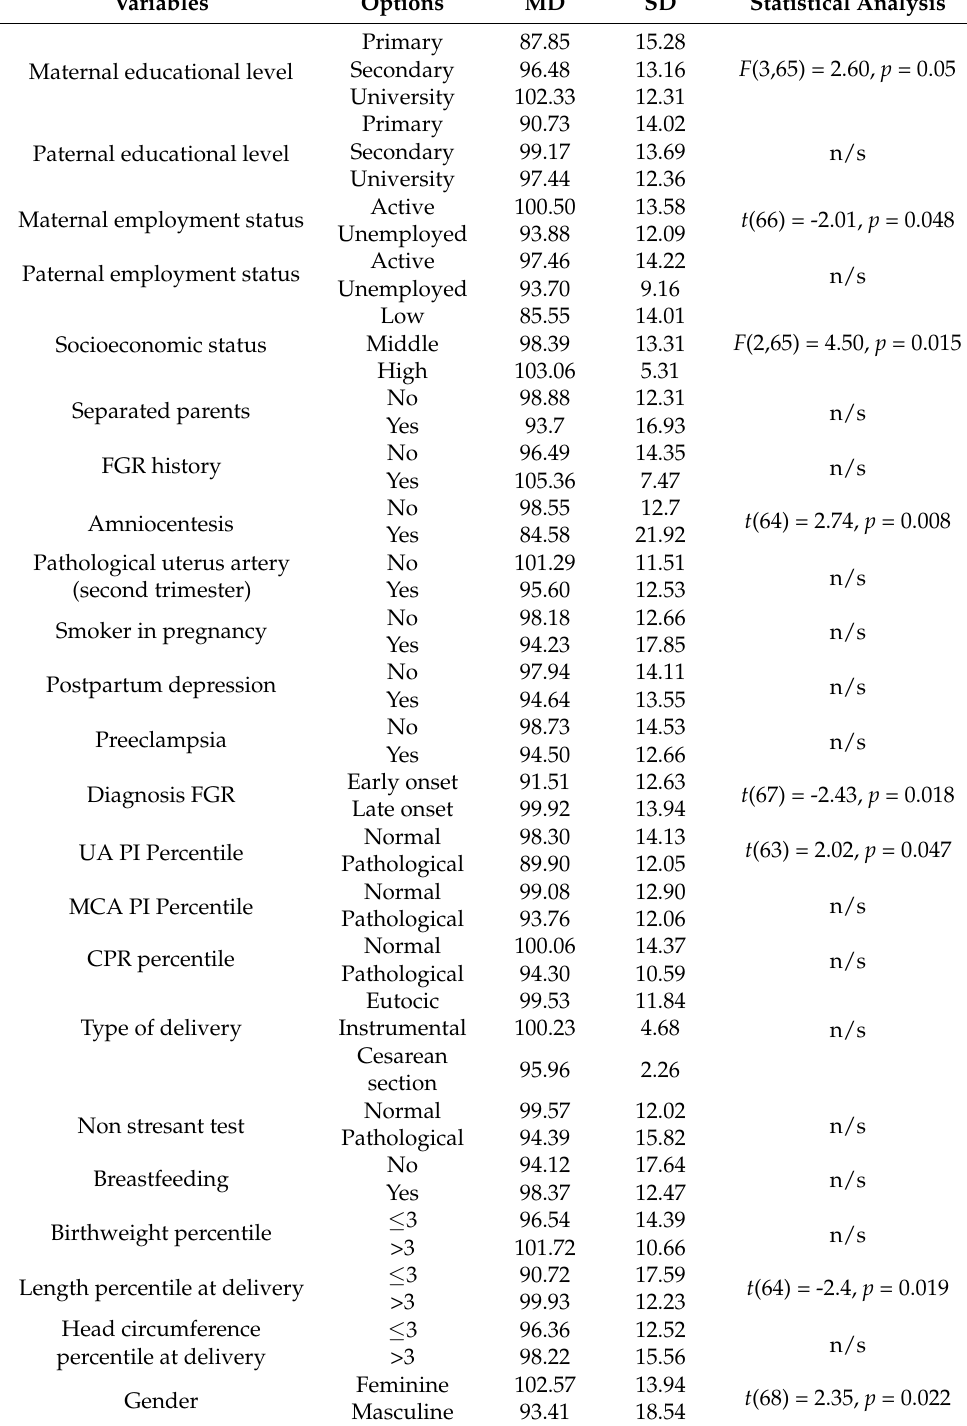
FGR: Fetal growth restriction, UA PI Umbilical Artery pulsatility index, MCA PI: Middle cerebral artery pulsatility index, CPR: cerebroplacental ratio, MD: mean values, SD: standard deviation, n/s: not significant. Early-onset FGR were linked to a lower quotient than late-onset (91.51 versus